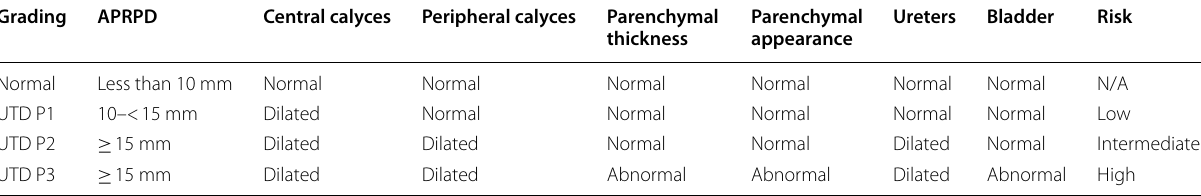
Table 2 Urinary tract dilatation grading